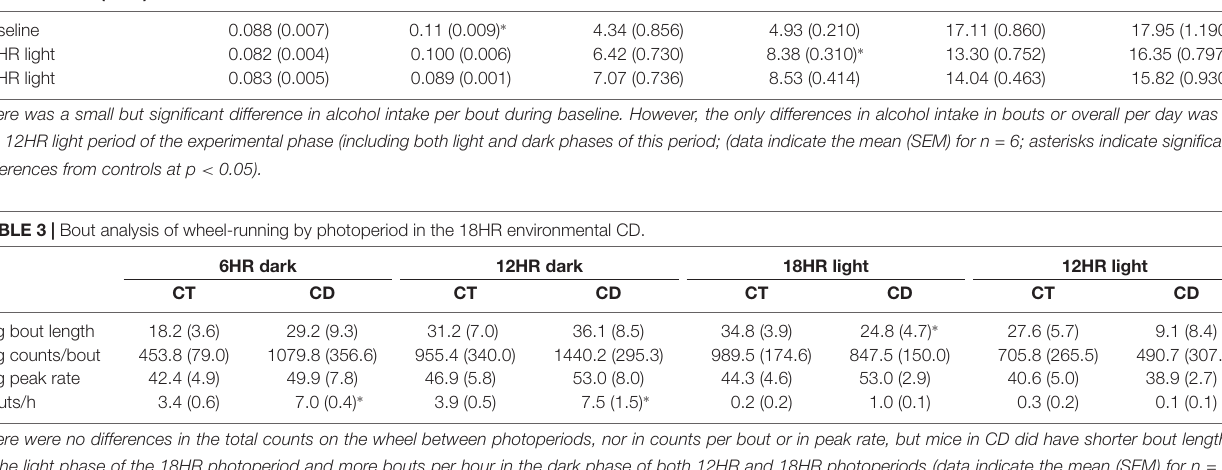
TABLE 2 | Analysis of alcohol intake in bouts (g/kg/min and total g/kg) and over 24 h (g/kg), based on photoperiod in Experiment 1. Alcohol intake (g/kg) Per bout Per day in bouts Total per day All data: mean (SEM) CT Baseline